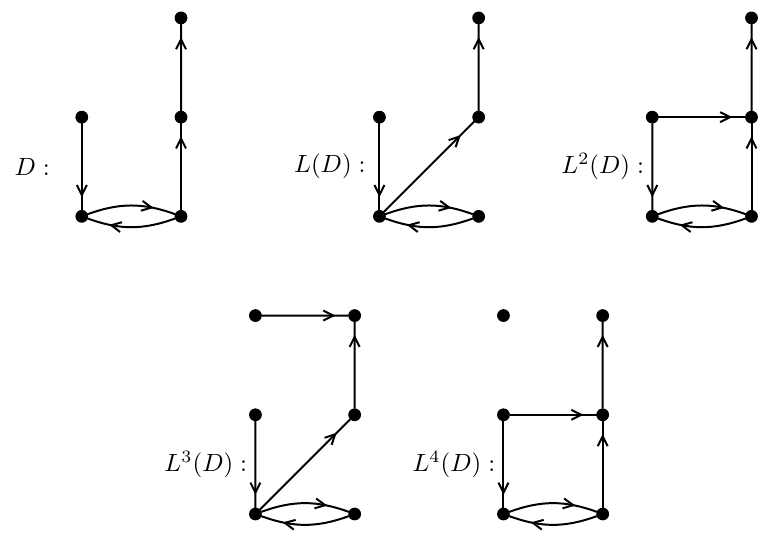
Figure 18: A digraph with period 2.